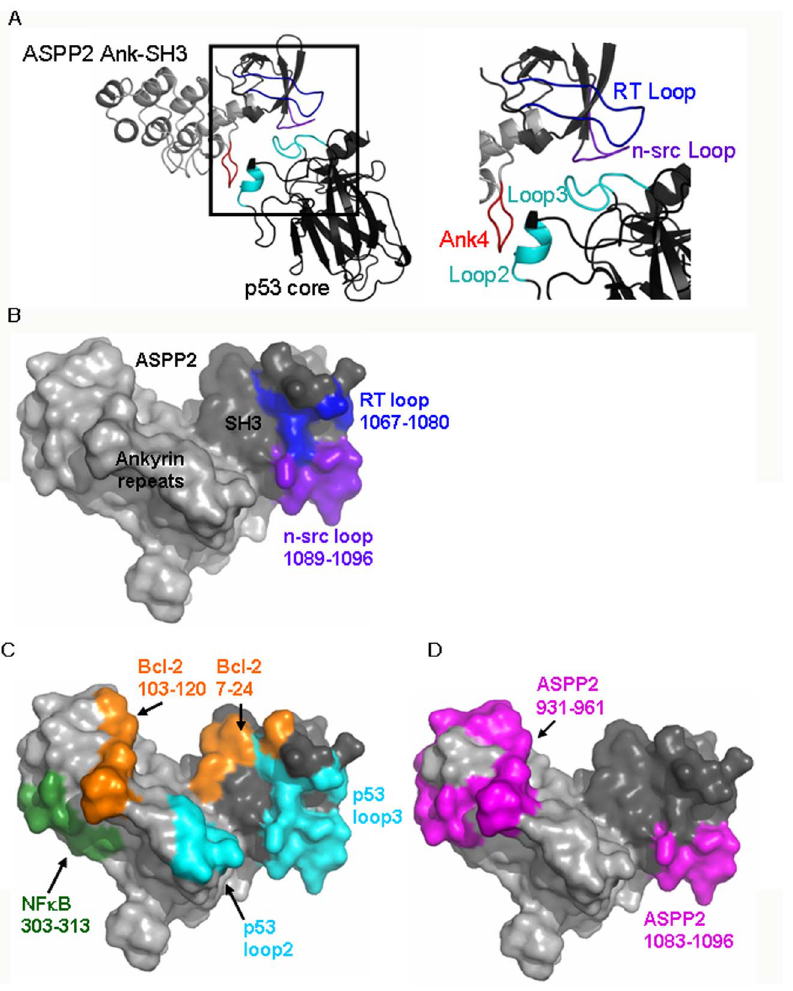
Figure 1. The ASPP2 Ank-SH3 – p53CD complex PDB ID: 1YCS [ 14 ] . (A) Crystal structure of the complex between p53CD (black) and ASPP2 927–1119 (gray). The RT loop (residues 1067–1080, blue) and the n-Src loop (residues 1089–1096, purple) in the ASPP2 SH3 domain bind the L3 loop of p53 (residues 241–249, cyan), while the fourth ankyrin repeat (residues 1020–1027, red) binds the L2 loop (residues 178–183, cyan) of p53CD [14]; (B) The structure of the four ankyrin repeats (light gray) and the SH3 domain (dark gray) of ASPP2. The p53CD binding sites in the ASPP2 SH3 domain of ASPP2 are shown with the RT loop in blue and the n-src loop in purple. (C) The binding sites of ASPP2 Ank-SH3 to p53CD (cyan), Bcl2 (orange) and NF k B (green) are all on the same face of the molecule but with minimal overlap between the binding sites [21]; (D) The ASPP2 Pro (residues 693–918) binding sites in ASPP2 Ank-SH3 (magenta) [13]. interaction between ASPP2 Pro and ASPP2 Ank-SH3: ASPP2 Pro